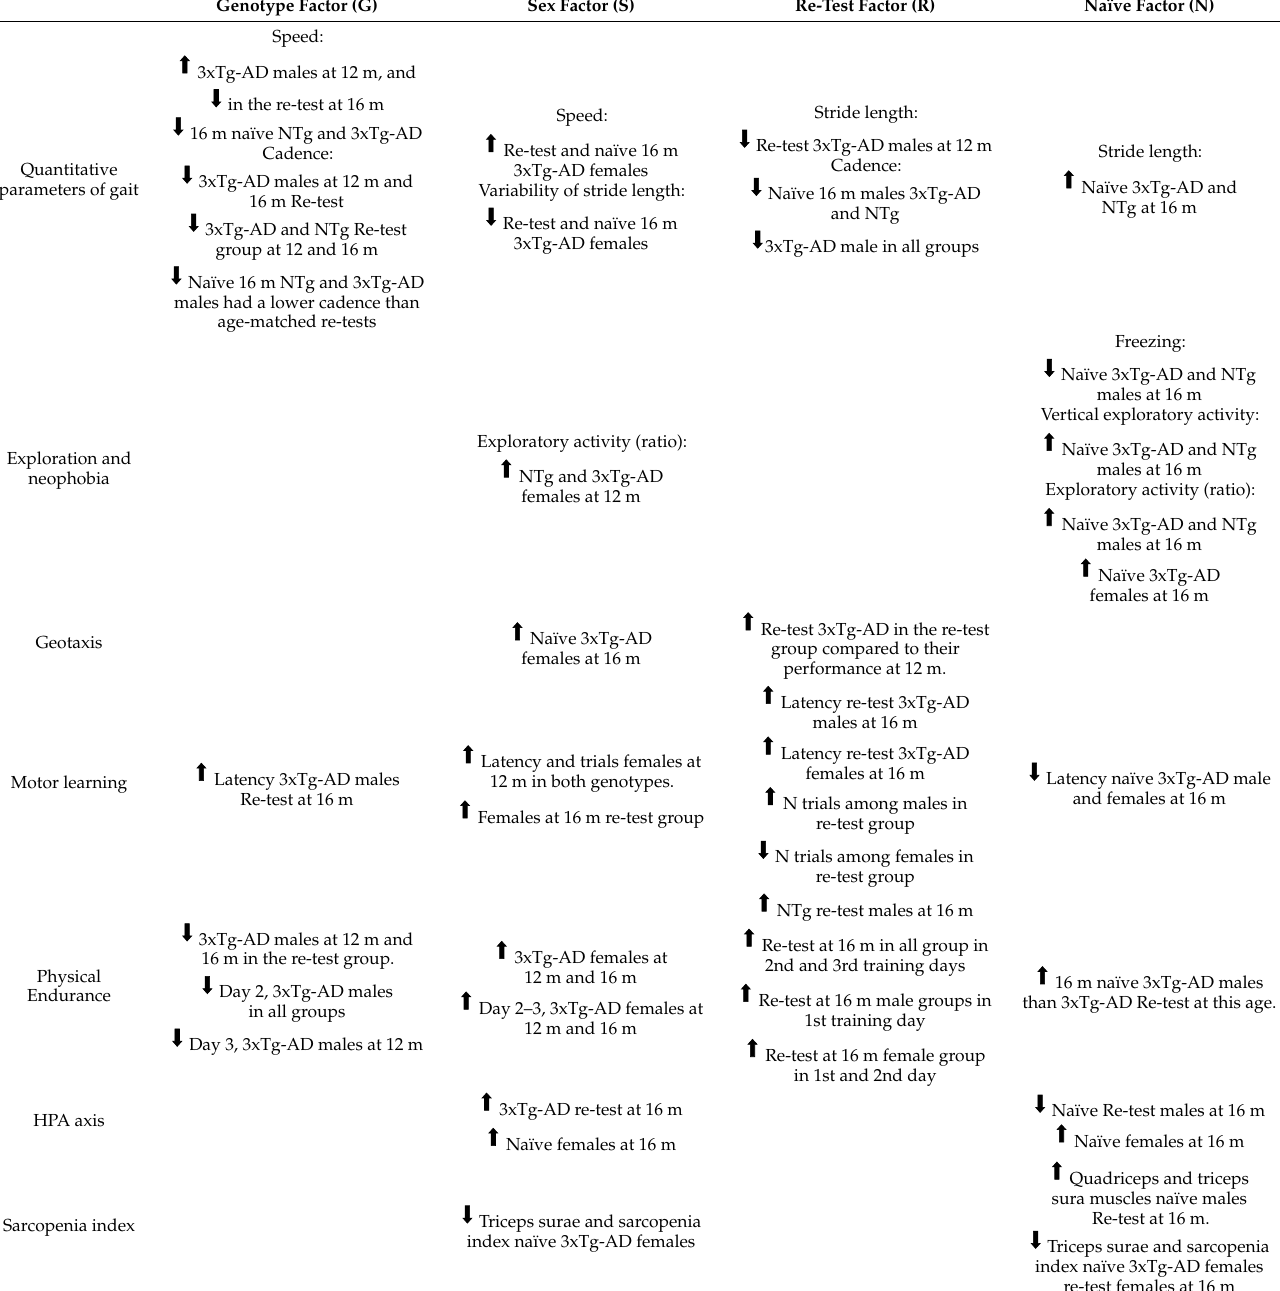
In males, negative correlations between corticosterone and quadriceps, triceps surae; and positive correlations between corticosterone and phenotype score system, frailty score, cadence, and physical endurance Day 1. Females, positives correlated between corticosterone and physical endurance-total, physical endurance Days 2 and 3. Correlation’s Positive correlations in males were detected between sarcopenia index-quadriceps and physical endurance on Days interactions 1 and 2. In females, negative correlations were detected between sarcopenia index–triceps and horizontal activity. Negative correlations in males were identified between phenotype score system and stride length, and in females’ phenotype score system and physical